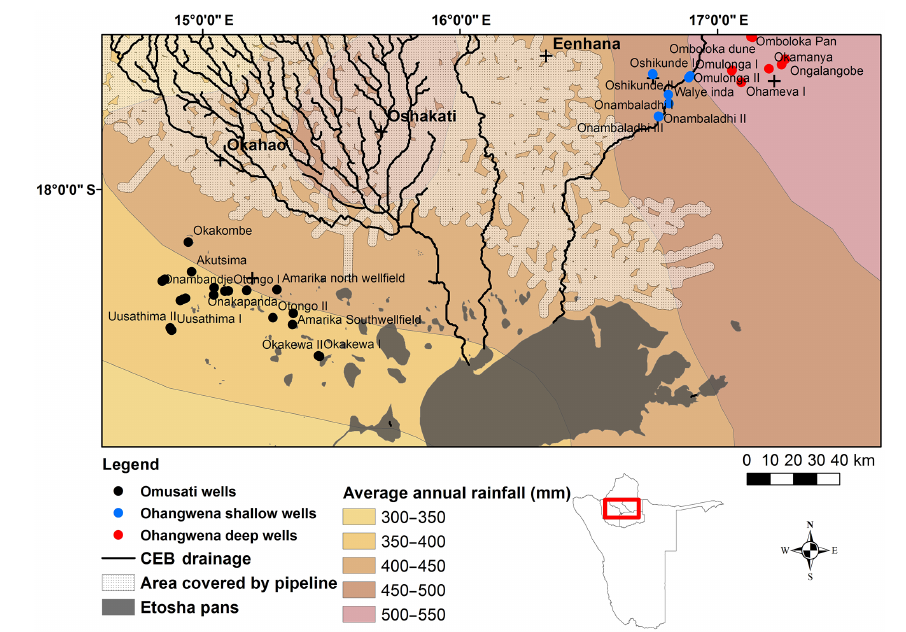
Figure 1. Location of the study area and sampling sites. The map also shows area that is connected to the national water supply